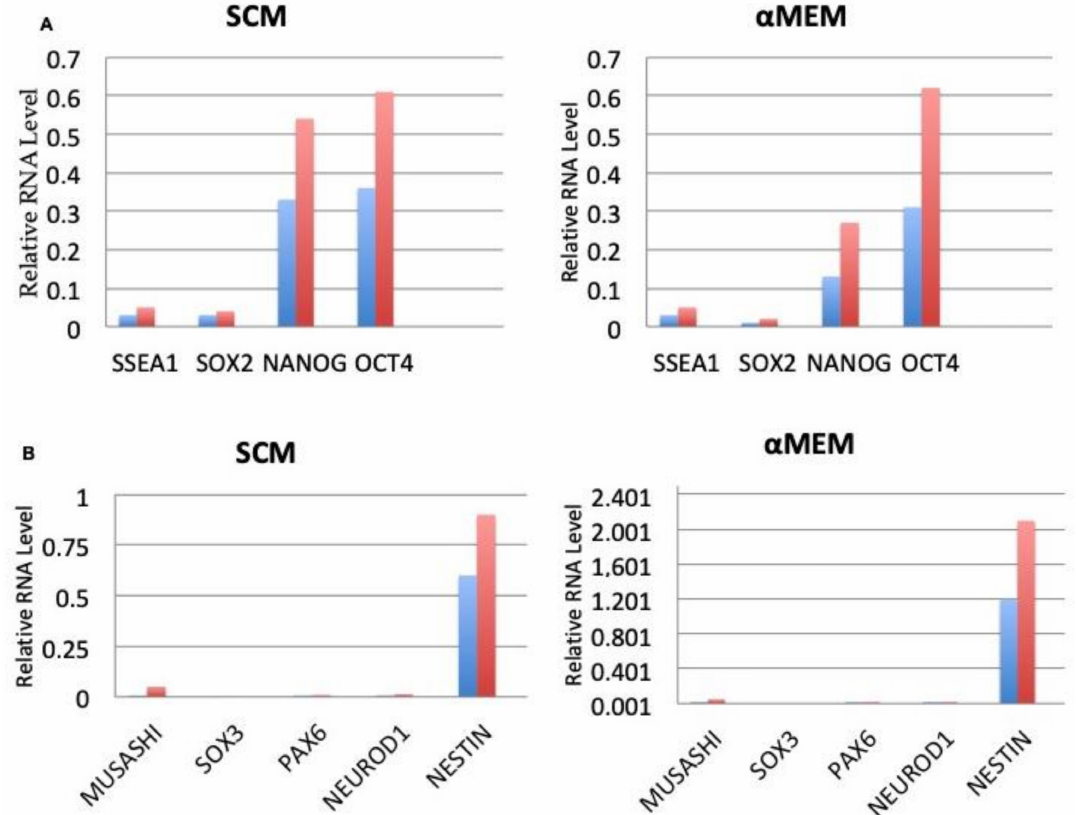
Figure 8. Pluripotency associated endogenous gene expression. ( A ) Expression of SOX2, NANOG, OCT4, SSEA1and ( B ) Expression of NESTIN, NEUROD1, PAX6, SOX3 and MUSASHI in FAT +